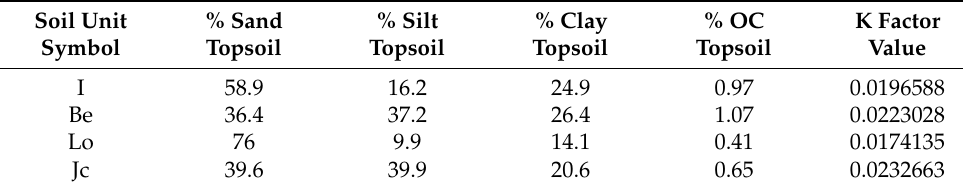
Figure 4. 30-year average annual, seasonal, and quarterly rainfall erosivity factors for the Chenab river catchment. Table 1. Soil erodibility factor value calculated for soil type in the Chenab river